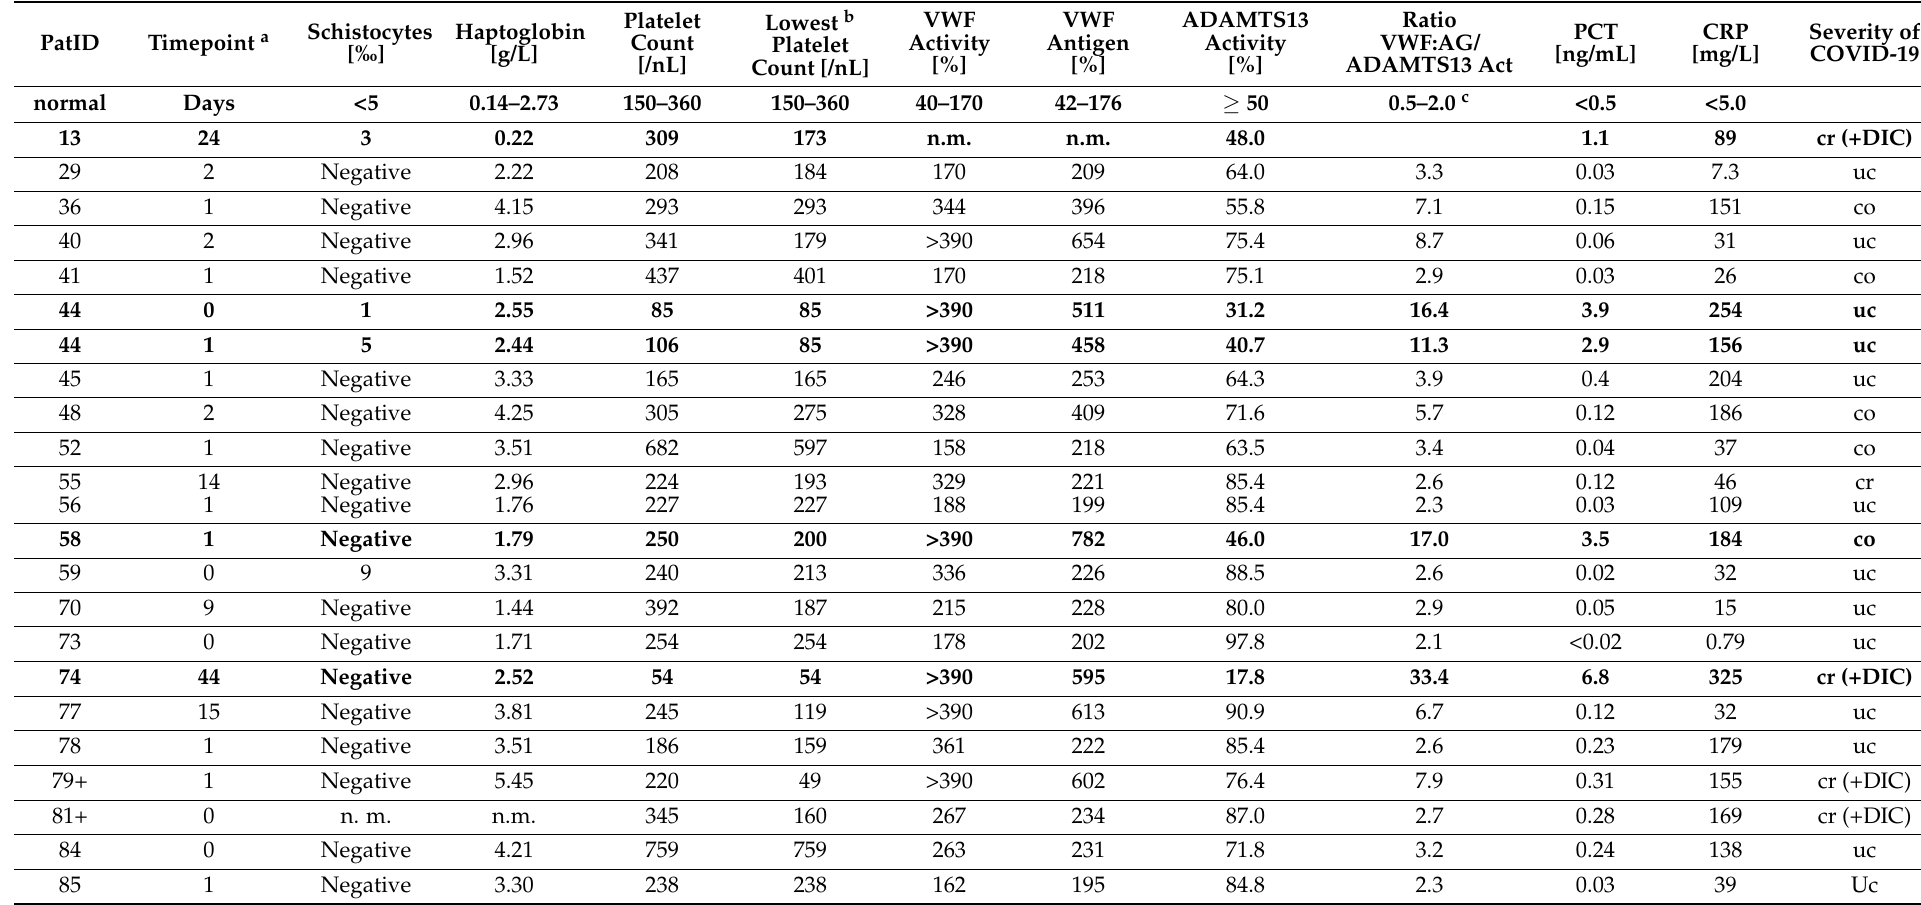
Table 4. Thrombotic microangiopathy-related factors of 22 comprehensively tested COVID-19 patients. All laboratory parameters were determined on the same day, except for the lowest platelet